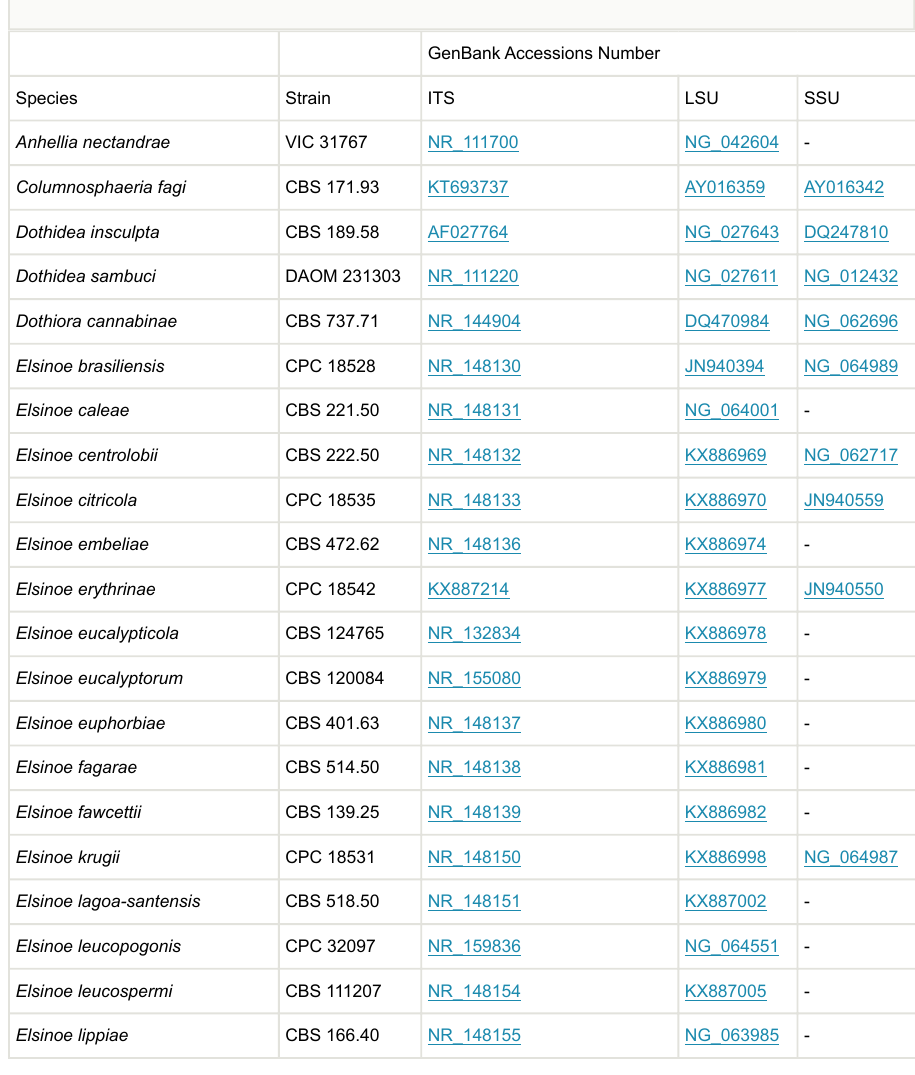
Table 1. Taxa used in this study for the phylogenetic analyses of combined SSU, ITS and LSU sequence data and their GenBank accession numbers. The newly-generated sequences are given in black